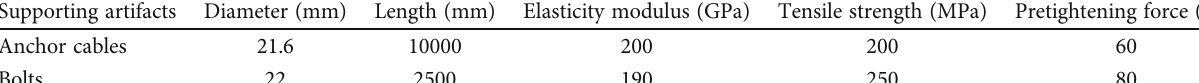
Table 2: Mechanical parameters of bolt (anchor cable) anchorage.